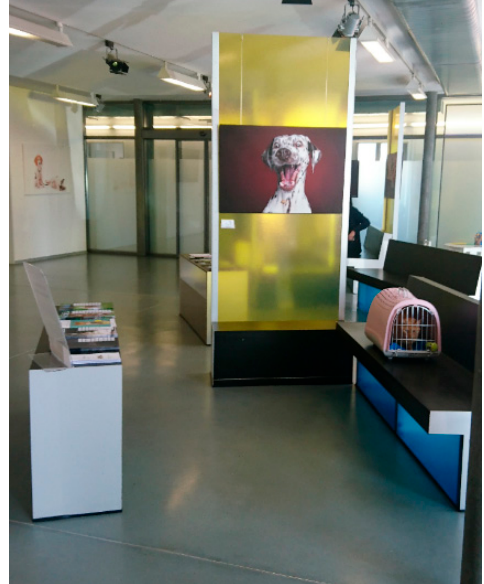
Figure 1. A spacious waiting area with visual barriers is ideal. Due to the layout of the benches, waiting animals do not need to face each other. Cat carriers should be placed on an elevated surface; ideal would be an additional covering of the carrier. Photo: Stefanie Riemer.